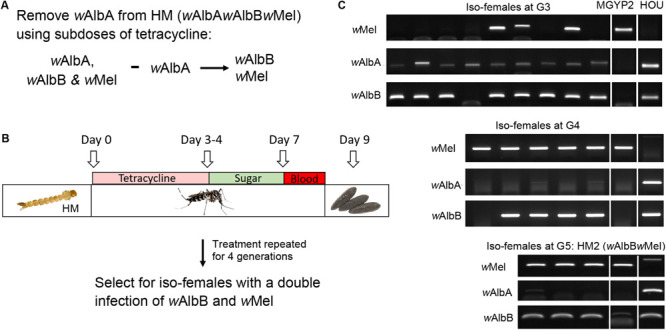
Establishment of the HM2 (wAlbBwMel) line carrying the double infection with wAlbB and wMel. (A,B) Schematic diagram of the experimental approach to remove wAlbA from the triply infected HM (wAlbAwAlbBwMel) line using subdoses of tetracycline. (C) Representative results from the PCR screening for isofemales carrying a double infection with wAlbB and wMel. wAlbA was specifically removed after treatment for four consecutive generations.